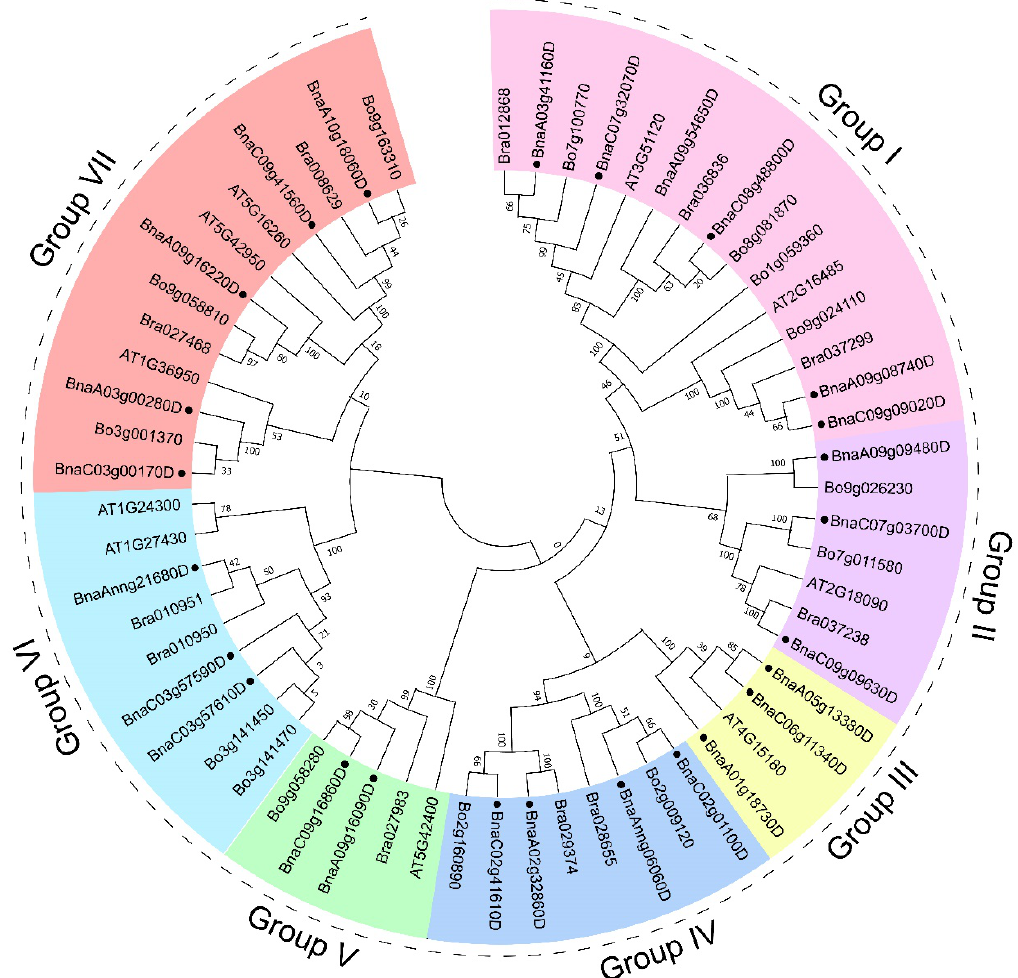
Figure 4. Phylogenetic tree of GYF proteins in B. napus ( • ), B. rapa , B. oleracea , and A. thaliana . The phylogenetic tree was generated by the NJ method with bootstrap analysis (5000 bootstrap replicates) using an amino acid sequence alignment of GYF proteins from B. napus ( • ), B. rapa , B. oleracea , and A. thaliana by the MEGA 11.0 program. GYF proteins were divided into 7 groups.